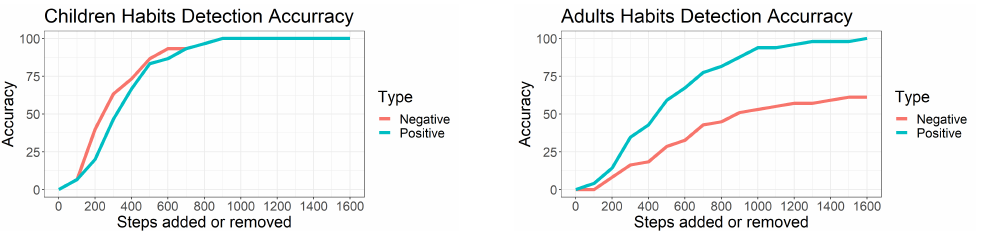
Figure 6. Left and right graphs show habit detection accuracy for children and adults, respec- tively. X − axis indicates number of steps added at 8 am (positive behaviour changes) or removed at noon (negative behaviour changes). Y − axis indicates percentage of habits detected in function of number of steps added. Red and blue lines indicate percentage of negative and positive habits detected,